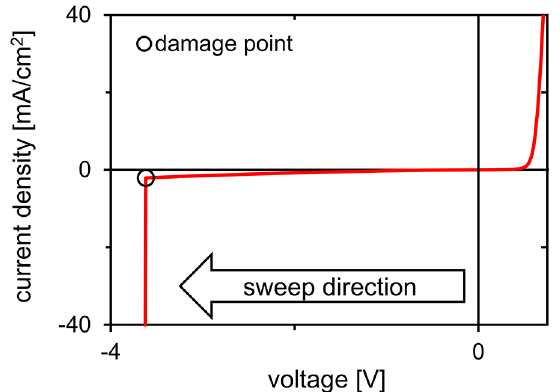
Fig. 1. JV graph of a cell that was damaged during the JV sweep. The moment when the cell was damaged and a wormlike defect started to form is accompanied by a sharp increase in current. This damage point is indicated with a black circle in the graph.